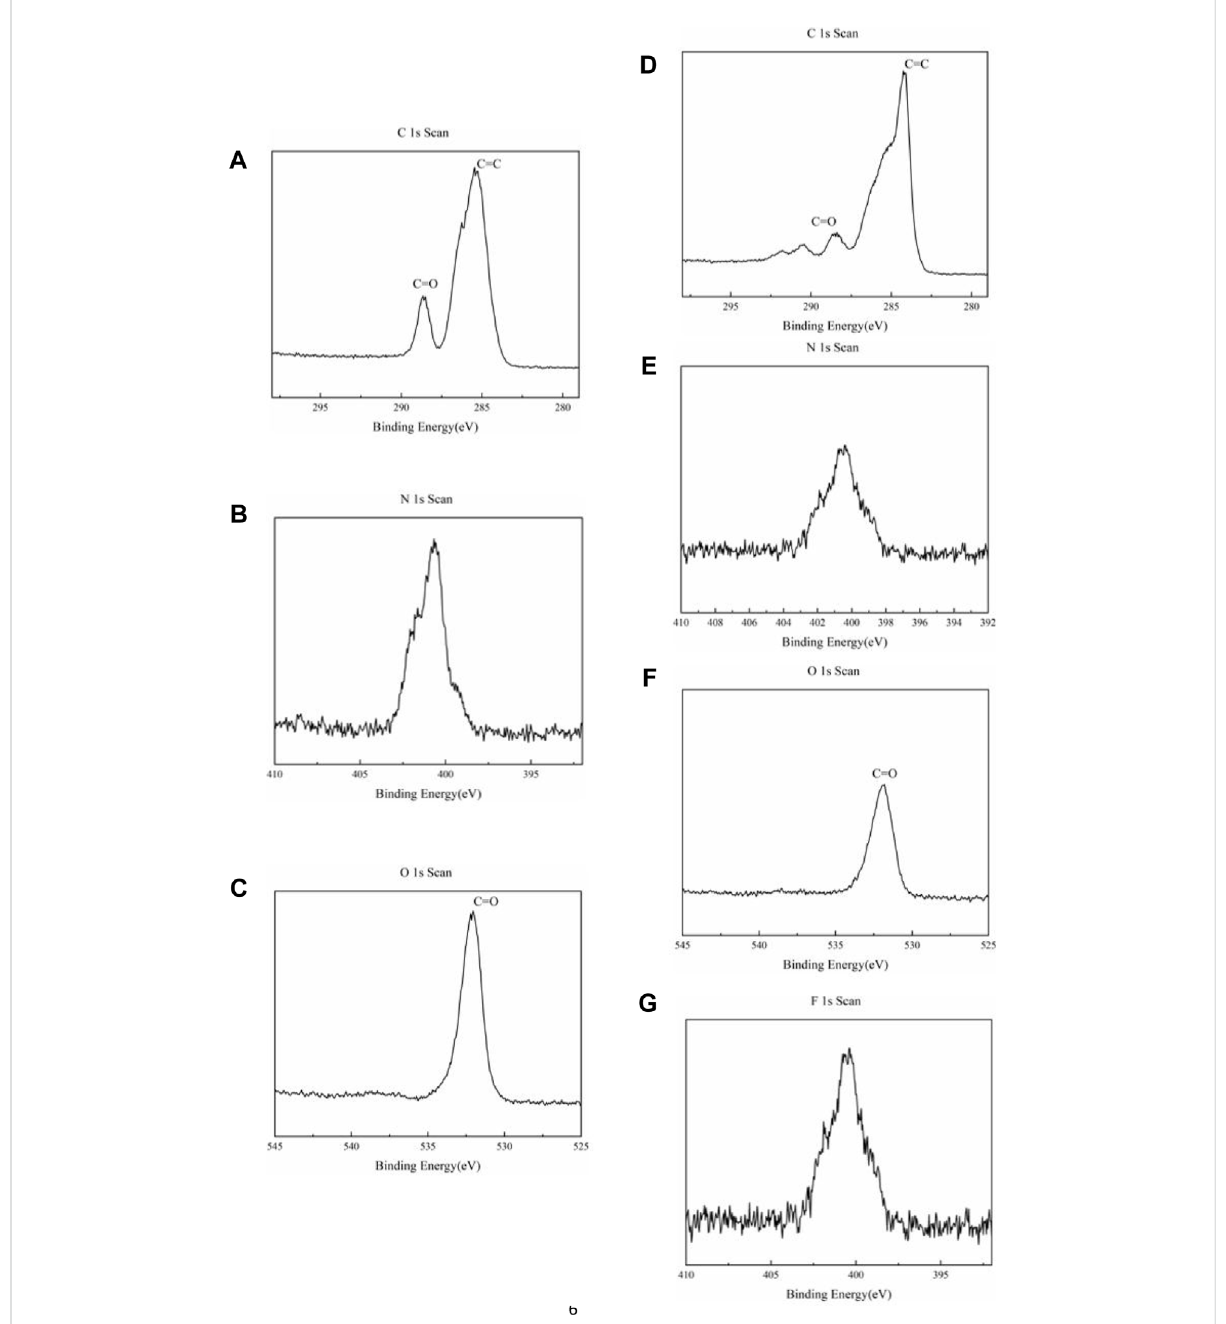
FIGURE 2 XPSspectraofNDI-NHOHsample: (A) Celement, (B) Nelementand (C) Oelement;XPSspectraofNDI-NHOHbasedelectrode: (D) Celement, (E) N element, (F) O element and (G) F